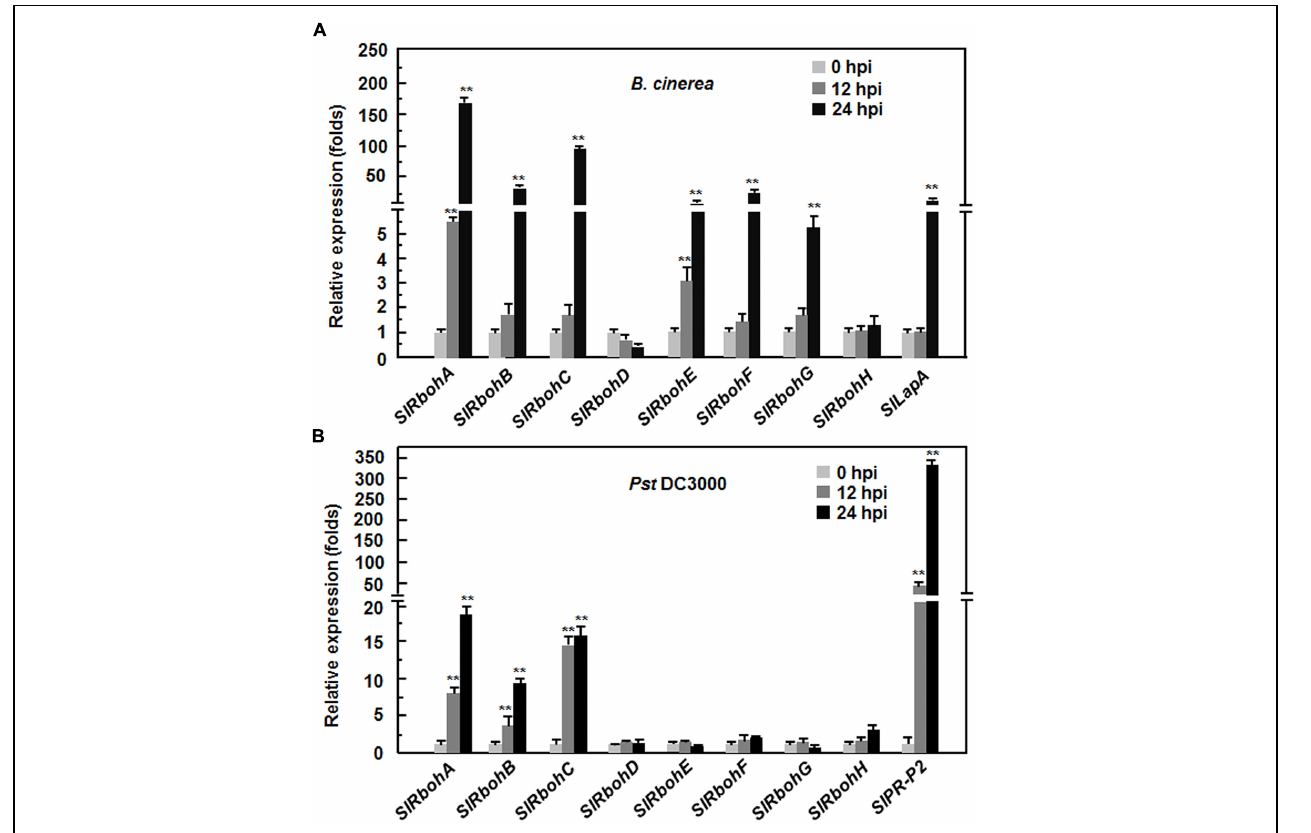
FIGURE 2 | Expression patterns of SlRbohs in response to Botrytis cinerea and Pst DC3000. Tomato plants were inoculated by foliar spraying with spore suspension (2 × 10 5 spores/mL) of B. cinerea (A) or vacuum infiltration with Pseudomonas syringae pv. tomato DC3000 (OD 600 = 0.0002), (B) and leaf samples were collected at indicated time